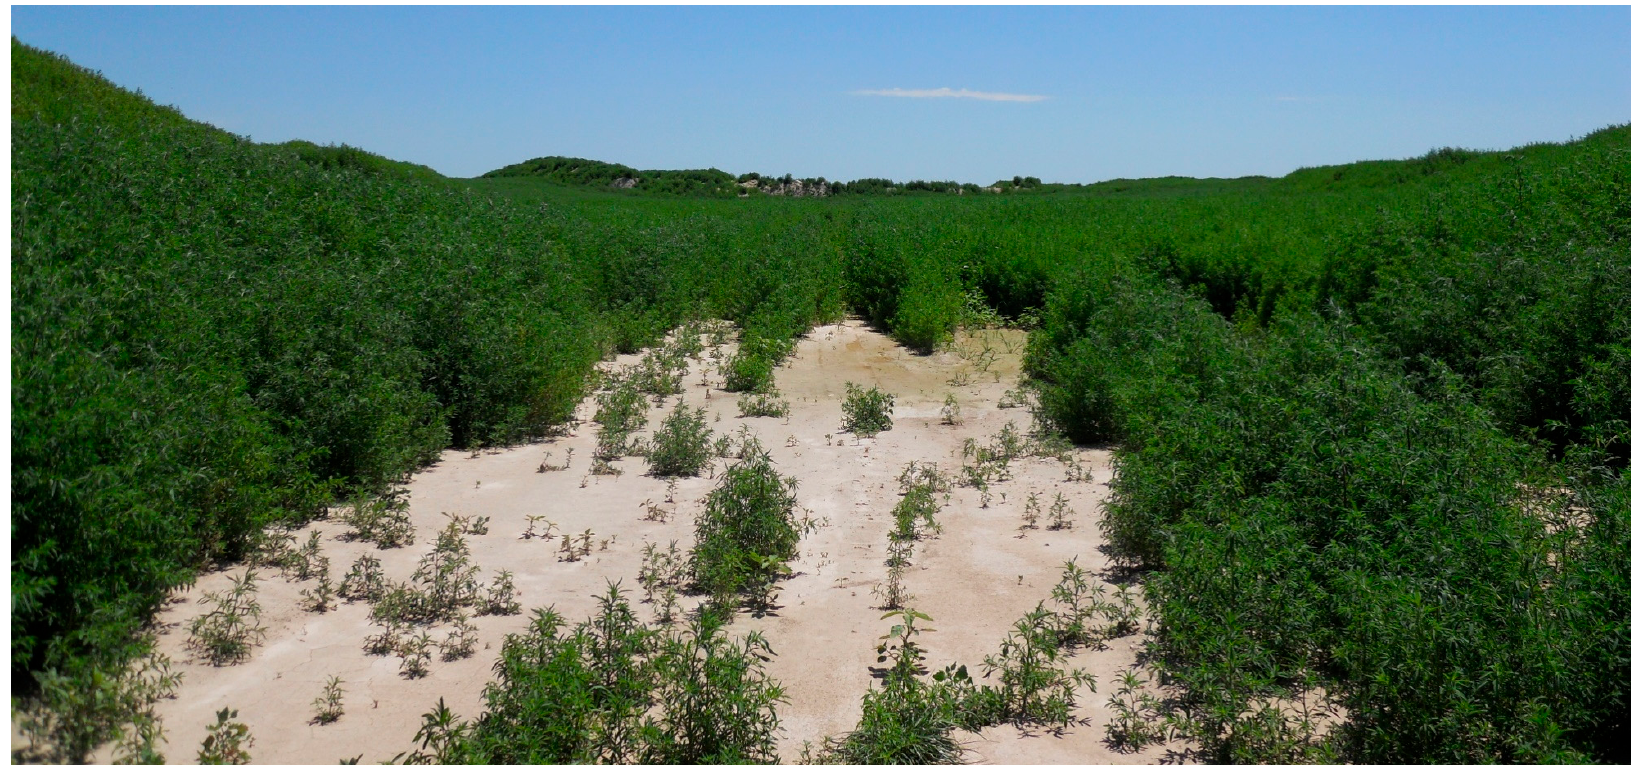
Figure 1. Kochia weed grown on precipitated calcium carbonate piles at sugar beet processing factory site in Scottsbluff, NE in 2011.